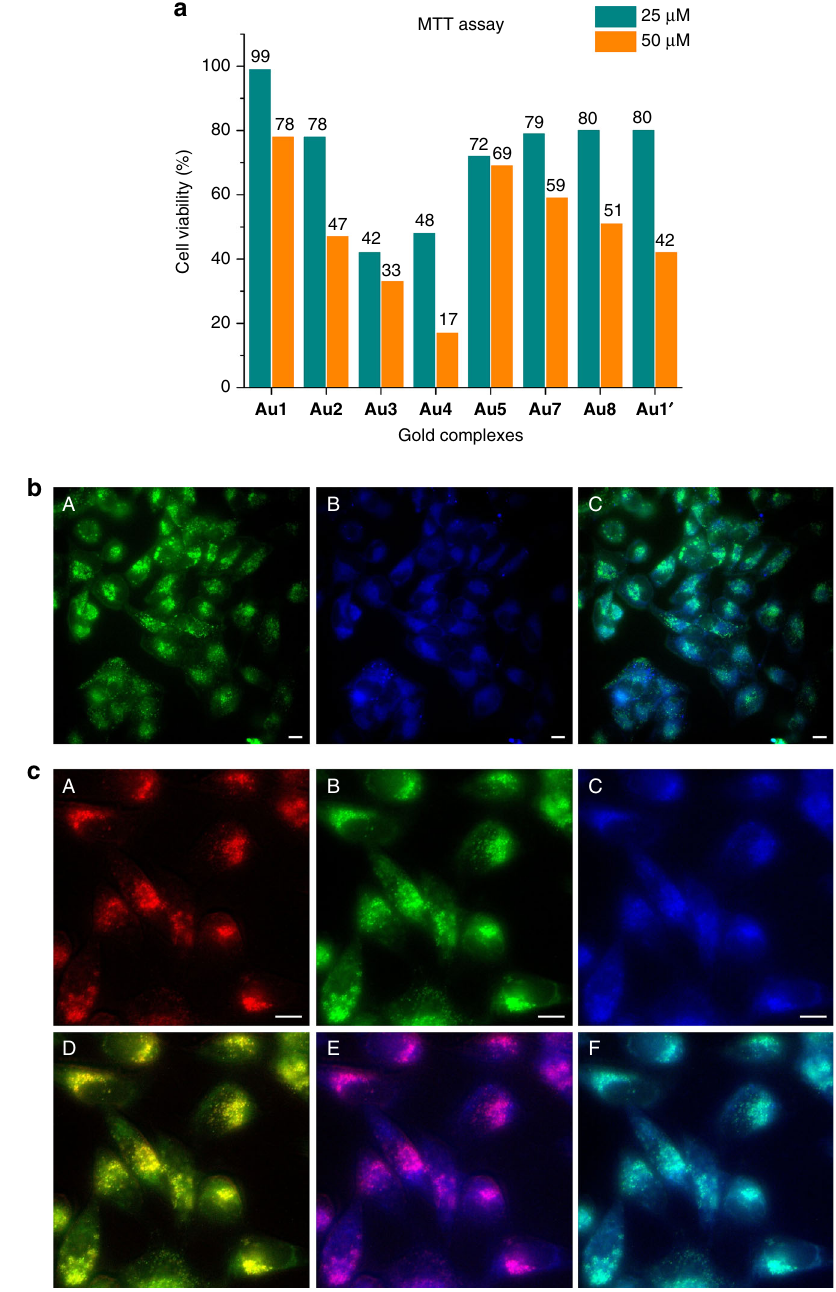
Fig. 3 Reactivity of gold complex Au1 in HeLa cells. a Bars representation of the cell viability. HeLa cells were incubated in cell culture medium containing the indicated amounts of the gold complexes for 6 h, and the amount of viable cells was analyzed using an MTT assay. The viability is expressed as the fold change of the fl uorescence/absorbance value with respect to untreated cells (value 1.0). Error in these measures was less than 6% (3 replicates). b (A) Fluorescence micrographies of cells incubated with the gold catalyst Au1 followed by addition of substrate 3 (green channel); (B) Similar experiment (blue channel); (C) Merging of A, B. c Subcellular localization of the catalytic activity of Au1 . (A) Lysosomal labeling with Lysotracker (red); (B) Fluorescence micrographies of cells incubated with the gold catalyst Au1 followed by addition of substrate 3 (green channel); (C) Similar experiment (blue channel); (D) Merging of A,B; (E) Merging of A and C; (F) Merging of B, C. Reaction conditions: Cells were incubated in DMEM with the gold complex (50 µ M in DMSO) for 30 min, followed by two washings with DMEM and treatment with substrate 3 (100 µ M) for 6 h. When using Lysotracker cells were incubated with 100 nM of this marker for 15 min. Scale bar: 12.5 µ